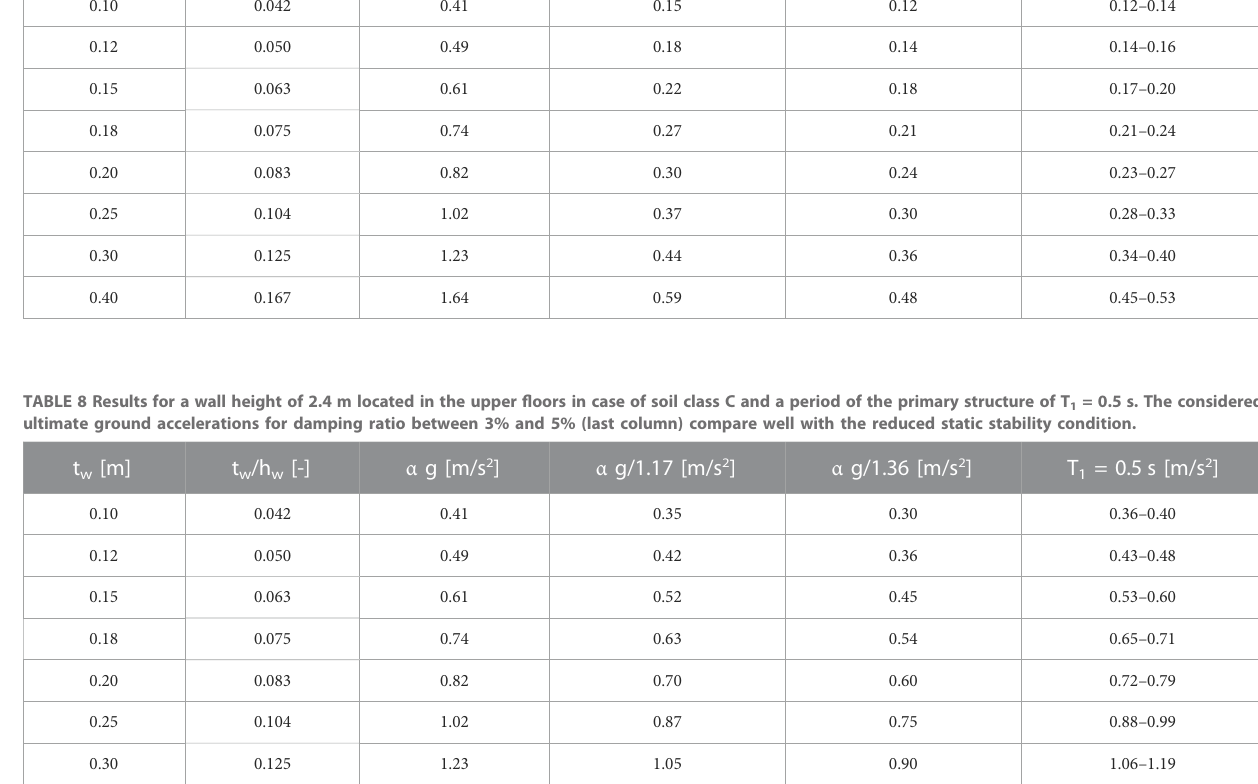
Table 8, for primary structure periods of T 1 = 1.5 s and T 1 = 0.5 s respectively. Note that even for the T 1 = 0.5 s case (Table 8), the